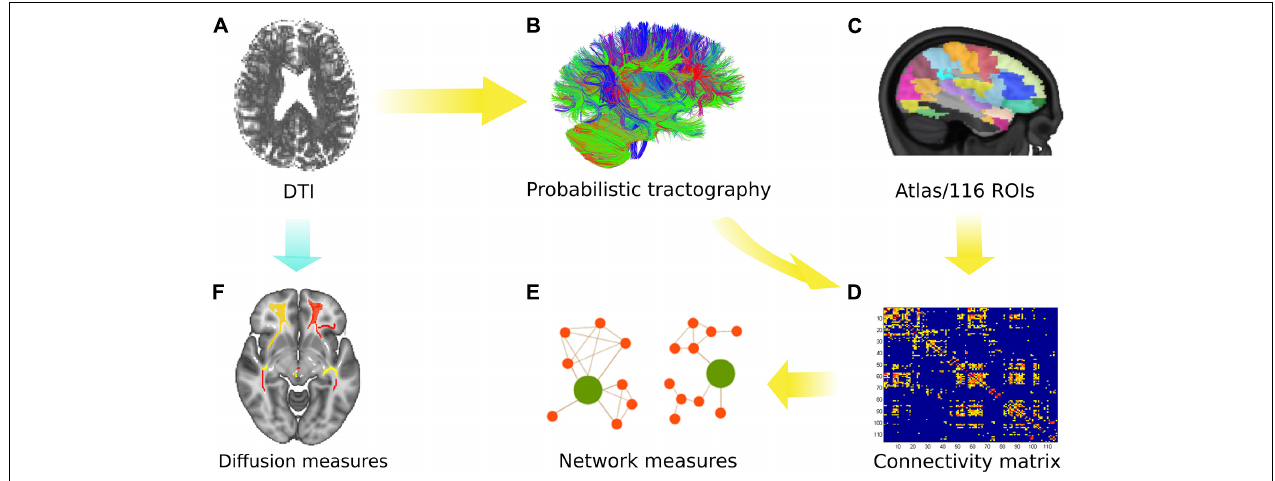
FIGURE 1 | Overview of the analytical approach. (A) Diffusion tensor imaging (DTI) was performed with all subjects. (B) Probabilistic tractography was used to obtain the connectivity matrix using the AAL atlas (116 ROIs) as depicted in (C) . (D) The connectivity matrix was generated depicting the probability from a seed to a target region (for 116 regions). (E) Network measures were obtained from the group comparison. (F) Microstructural analysis was performed using various diffusion measures identified after tract-based spatial statistics (TBSS) and permutation